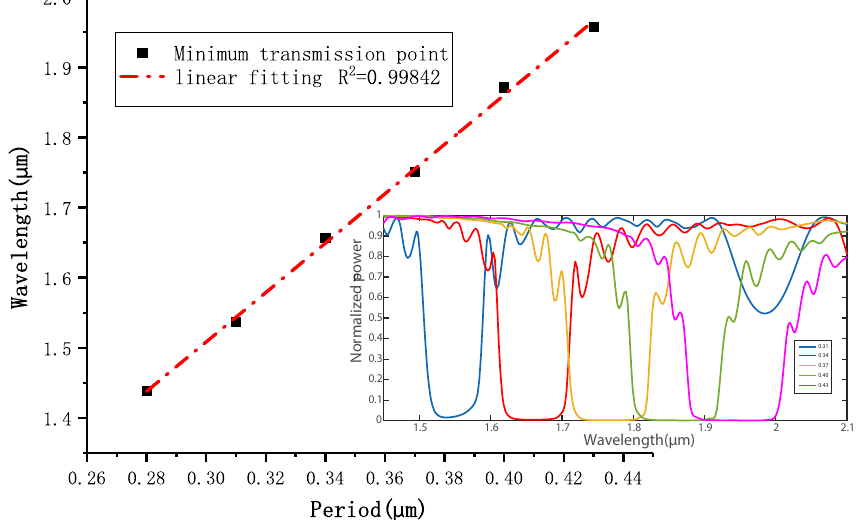
Figure 10. The band gap versus the Period. The insert shows the band gap drifting with the increasing of the